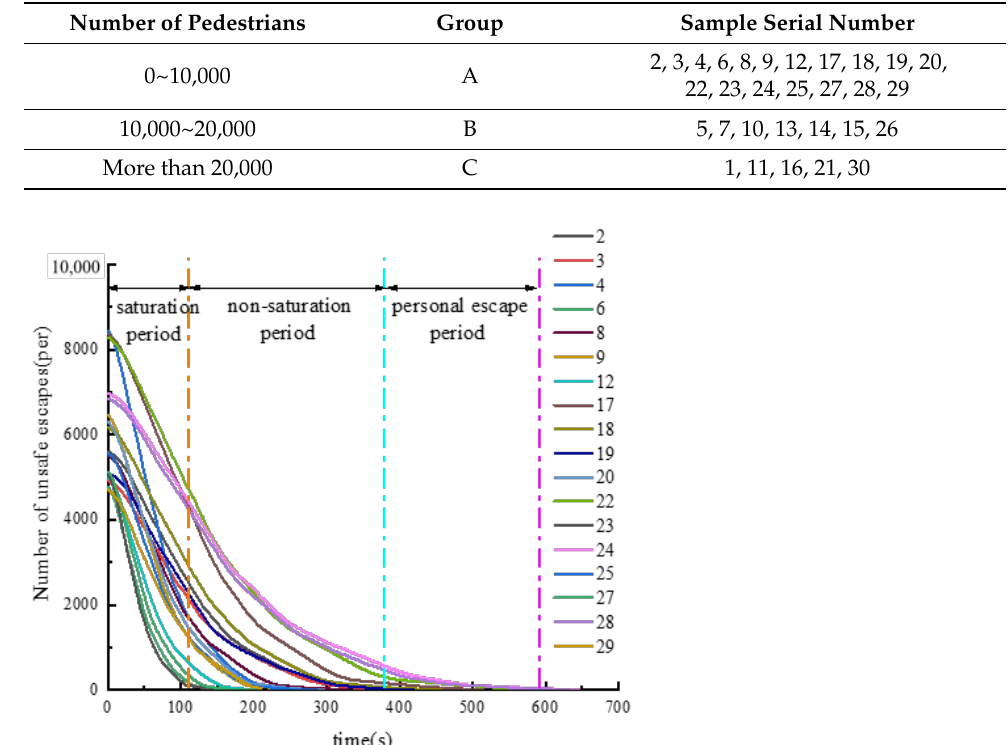
Table 4. Sample groupings.